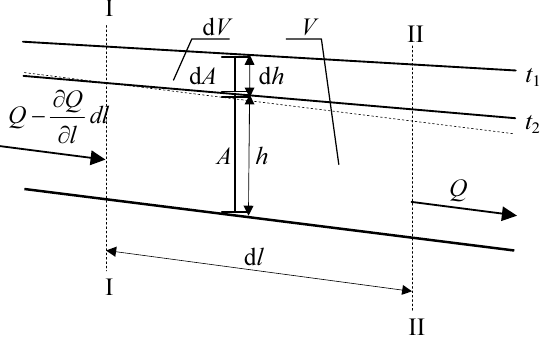
Fig. 5. Dimensions of water flow section for application of (8)